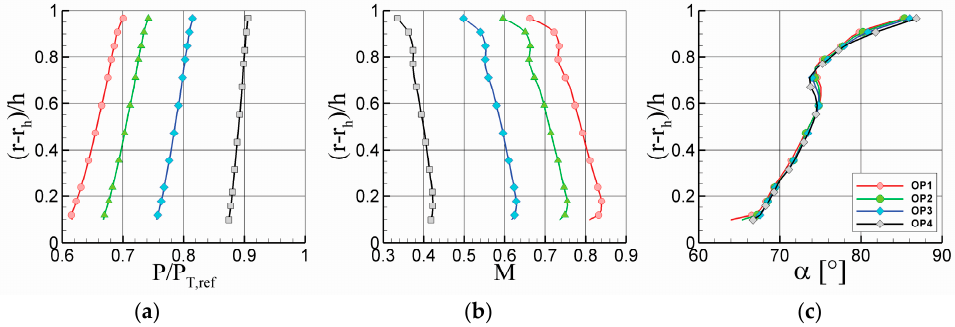
Figure 5. Span-wise profiles downstream of the stator, ( a ) expansion ratio; ( b ) Mach number; ( c ) absolute flow angle. Coloured legend applies to all